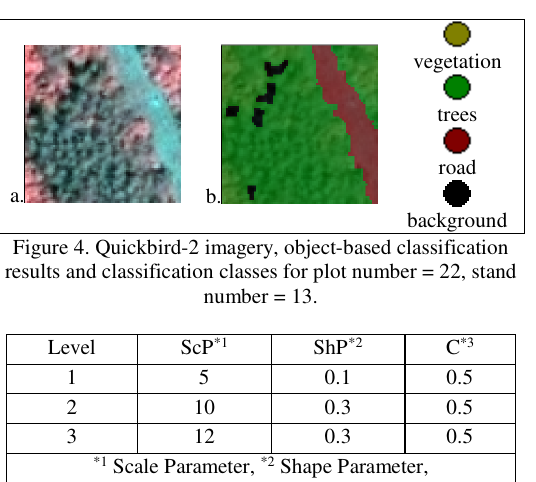
Table 3. Classification ruleset for plot number = 3.